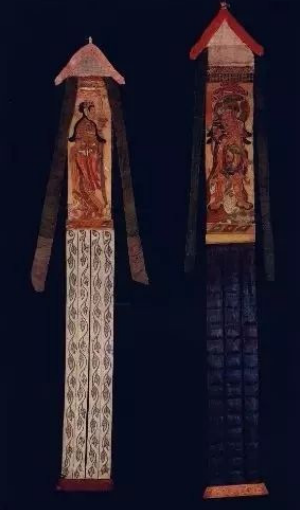
Figure 5. Chuang Fan.